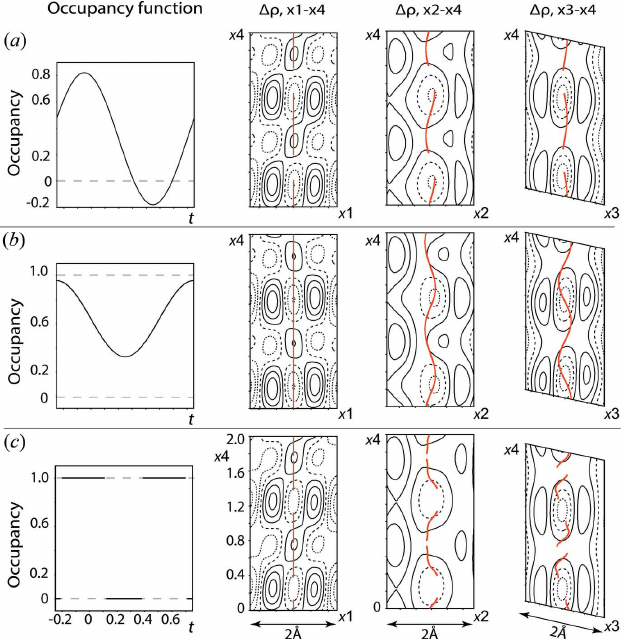
Figure 2 Three possible models of the Pt5 occupancy function and the corresponding Fourier maps of the residual electron density ( (cid:2) (cid:2) ) calculated for the vicinity of the Pt5 position. ( a ) The harmonic function applied without any restriction, ( b ) the harmonic function constrained by ocos1 = 0 and ( c ) the crenel function; all of them give low values of (cid:2) (cid:2) . Red lines show the position modulation functions of Pt5. The black solid, dashed and dotted lines indicate positive, zero and negative contours, respectively, with a step of 0.5 eA˚ (cid:2) 3 .